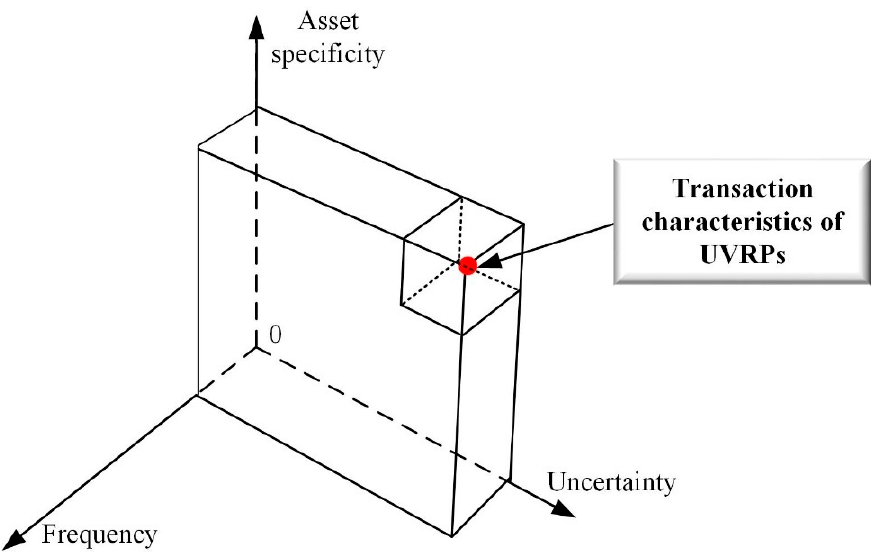
Figure 1. Transaction characteristics of UVRPs.